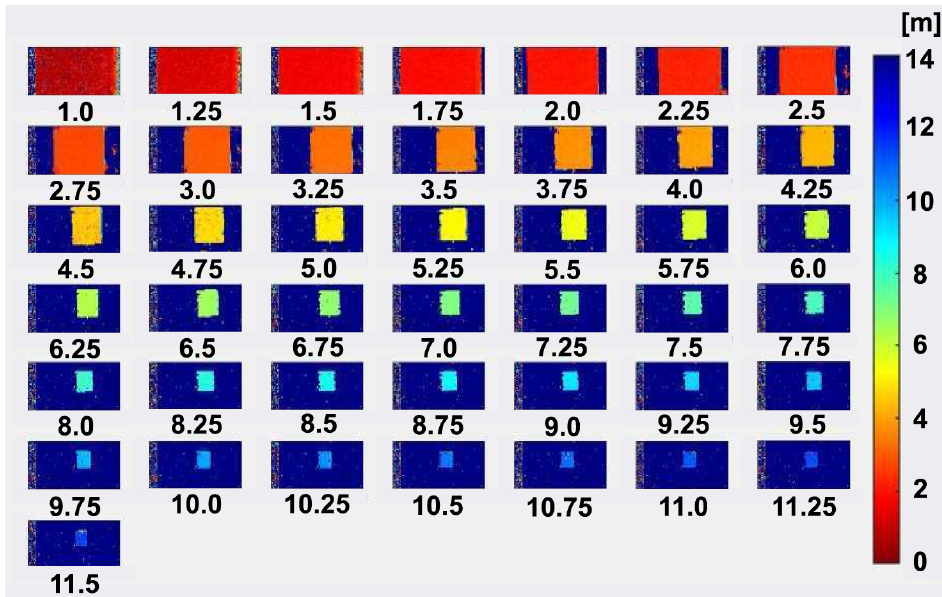
Figure 11. Depth image (1.0 m to 11.5 m) while moving a re fl ector board.